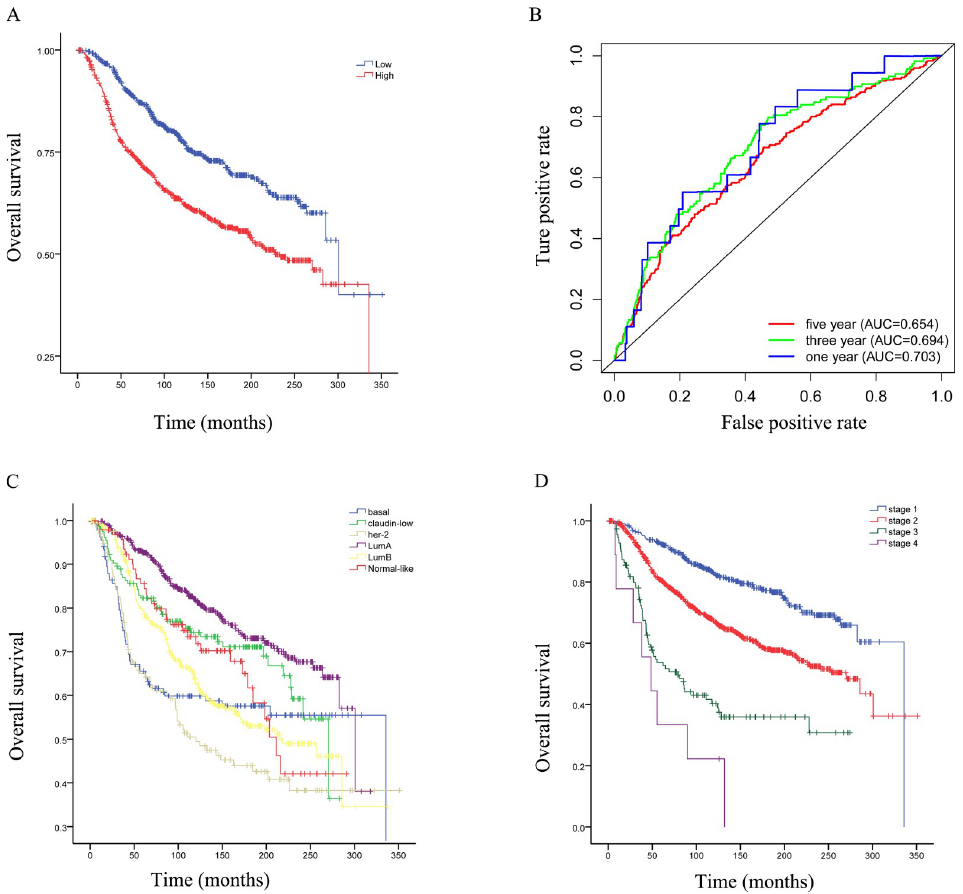
Fig 5. Overall survival and ROC curve. (A): Breast cancer patients with High-RRM2 expression have poor overall survival compared to those with Low-RRM2 expression. (P < 0.05). (B): The ROC curve shows the diagnostic value of RRM2 for patients with breast cancer. (C): Overall survival analysis showed that patients with the Luminal A subtype of breast cancer have the best prognosis, and the Basal-like subtype has the worst prognosis in 1,350 breast cancer patients. (D): The high expression of RRM2 has poor overall survival in stage 1 and stage 2 breast cancer patients. (P < 0.05).